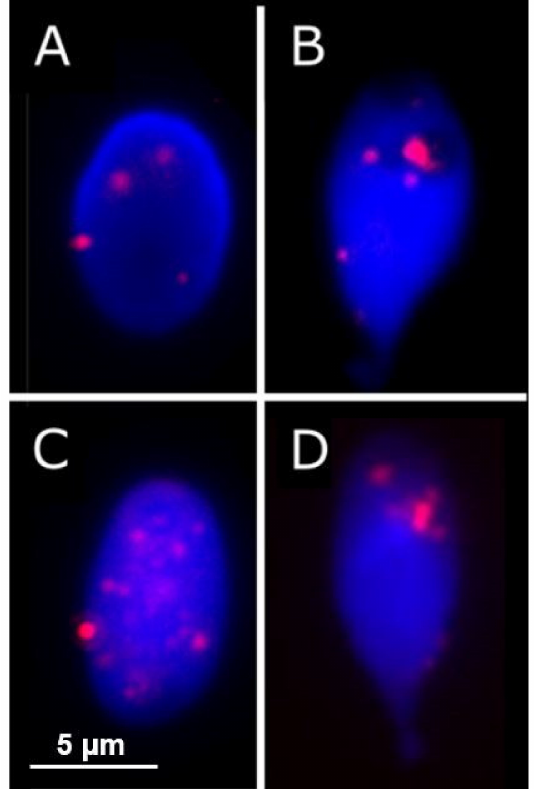
Figure 3. The nuclei with the smallest and largest differences from the average shape, for both control ( A , B ) and infertile cohorts ( C , D ), as measured by the difference in nucleus shape profiles from the median profile (see [36] for technical details). Shape abnormalities are similar in both but are more prevalent in the infertile cohort Red spots represent telomeres, whereas the nuclear volume is represented by a blue nucleic acid stain